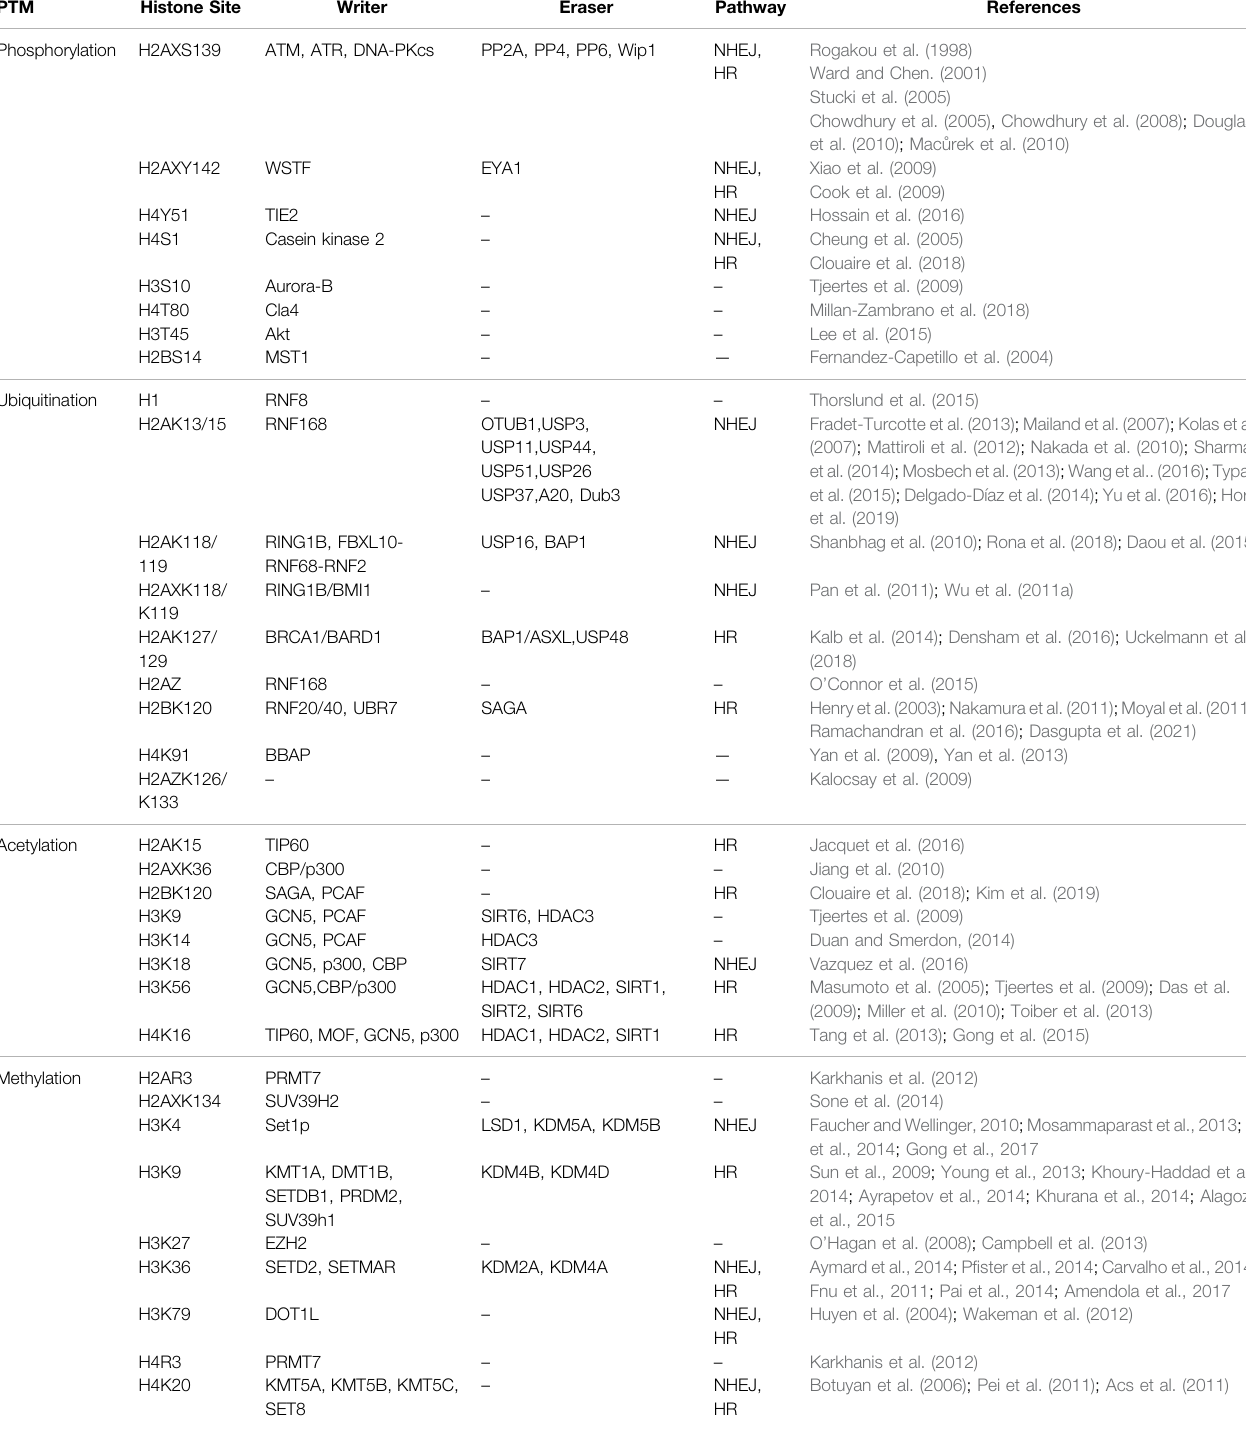
TABLE 1 | Histone modi fi cations in the